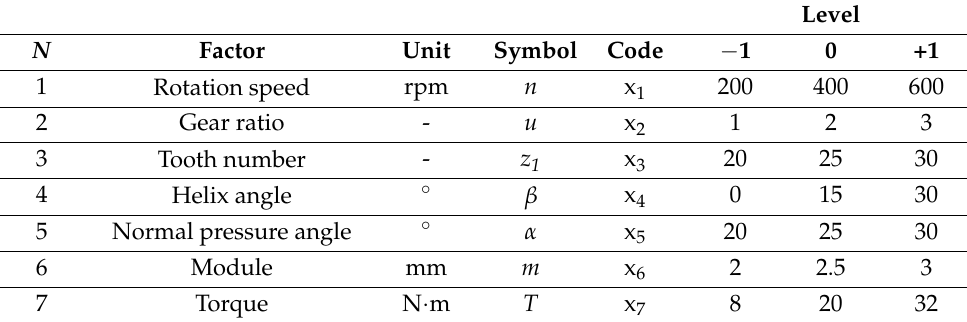
Table 1. Initial levels of factors influencing gear efficiency.